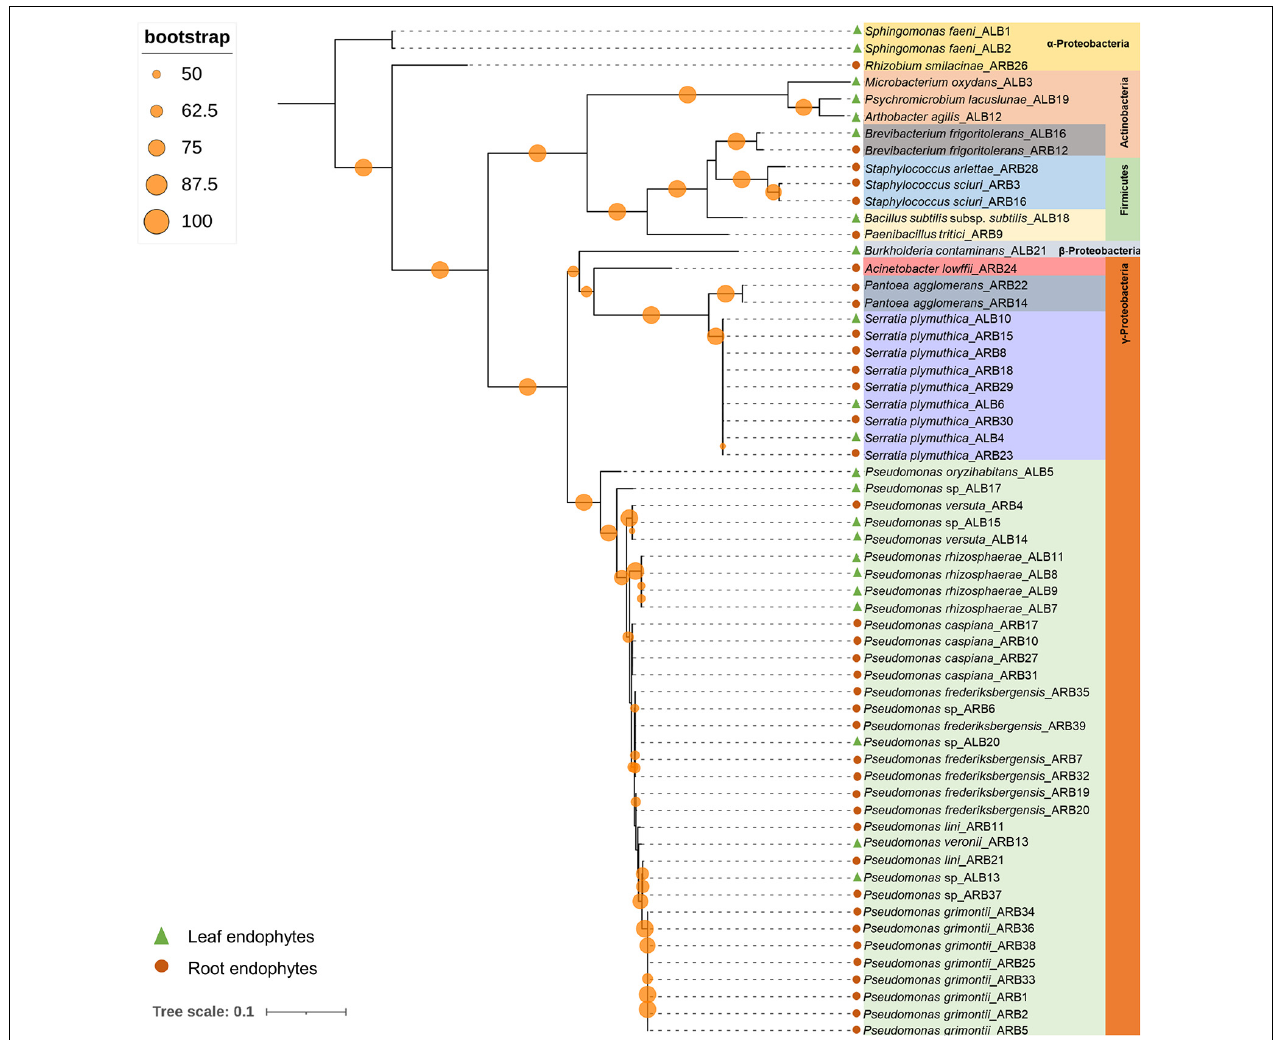
FIGURE 1 | Phylogenetic relation among bacterial endophytes isolated from A. euchroma leaf and root tissues. A total of 60 bacteria were isolated and analyzed for reconstruction of phylogeny using the Maximum Likelihood method with bootstrap replication of 1,000. A reoccurrence frequency of ≥ 50% is indicated on the node by a circle. A solid circle and triangle before taxonomic designation indicate root and leaf endophyte,